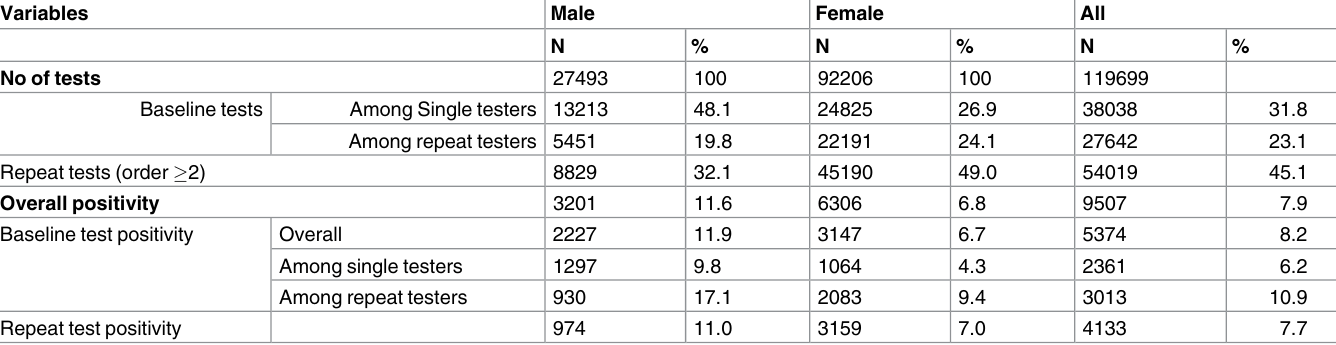
Table 2. Description of positivity rates among single and repeat tests performed at the YHC in Stockholm County 2010–2012. Variables